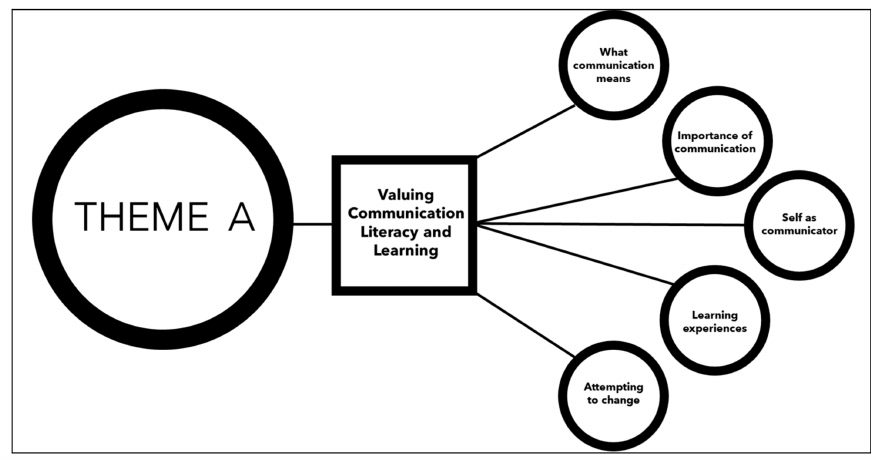
Figure 2. Theme A—valuing communication, literacy, and